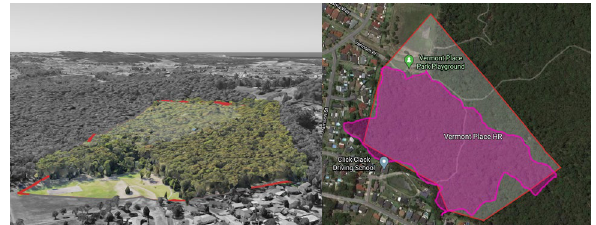
Figure 6: Vermont Place Park, Newcastle,